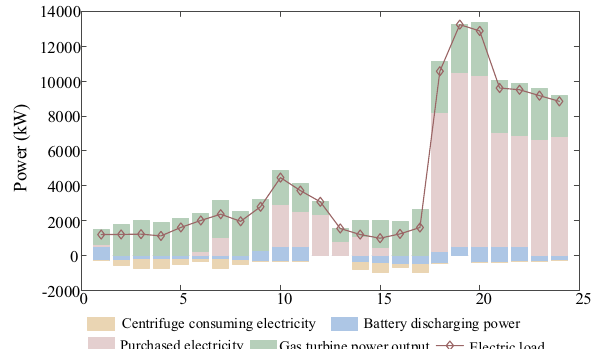
Figure 10. Electricity supply and demand of case 2.